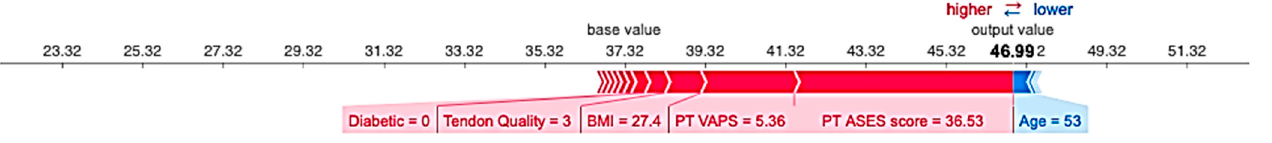
Figure 7. Contribution of various features obtained using SHAP on the prediction of change in 12- 12-month post-operative ASES score for a test dataset month post-operative ASES score for a test dataset patient.